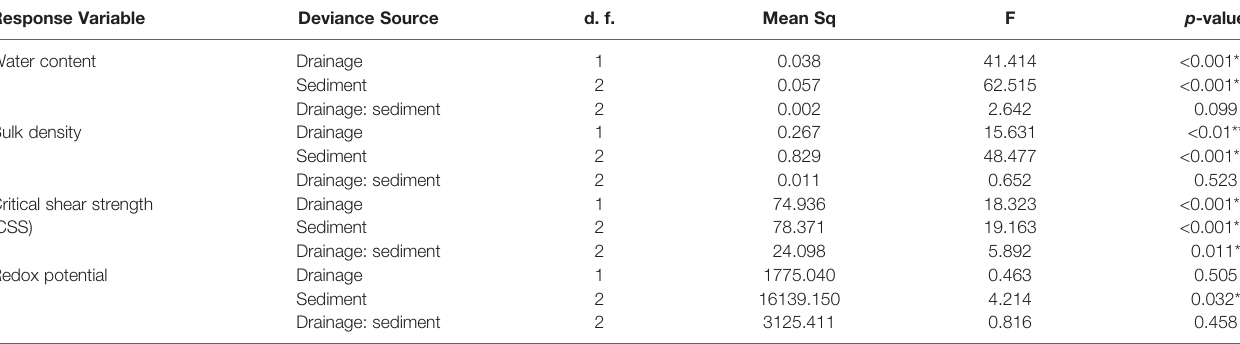
TABLE 5 | Two-way ANOVAs table show effects of drainage, sediment, and their interactions on sediment properties in the mesocosm experiment. Response